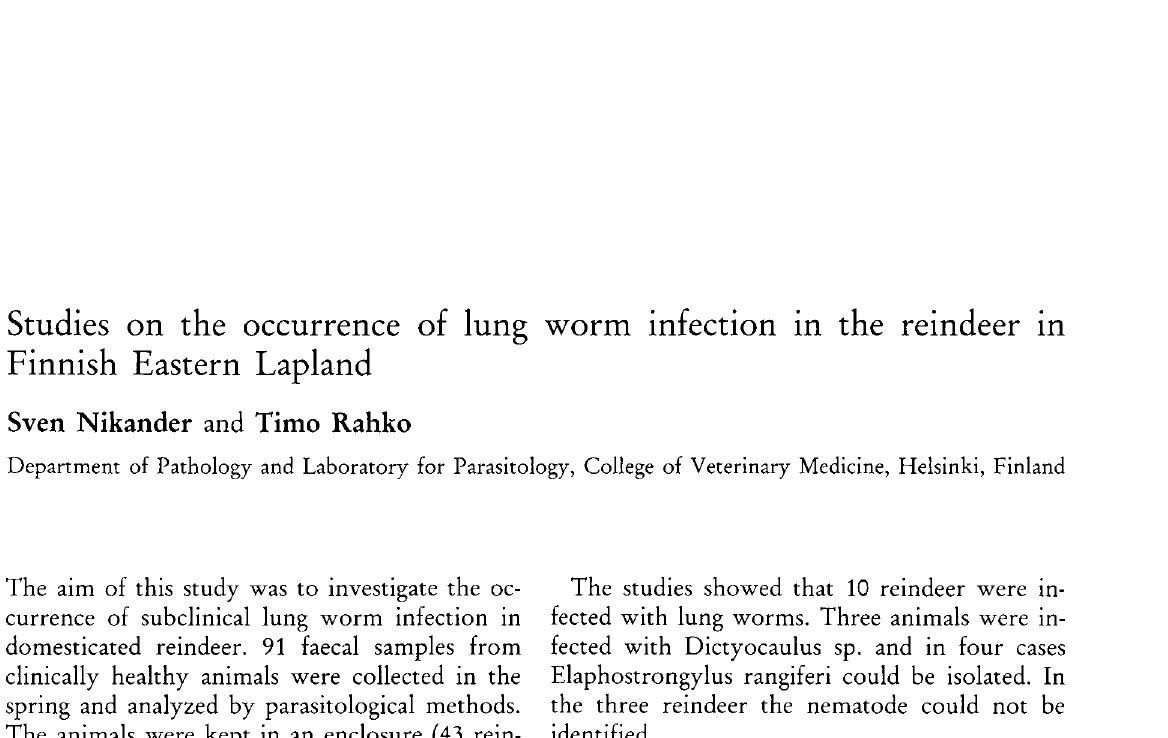
Table 1. The occurrence of lung worm larvae in fae cal samples of 79 clinically healthy reindeer successfully treated previously with anthel- minthics.